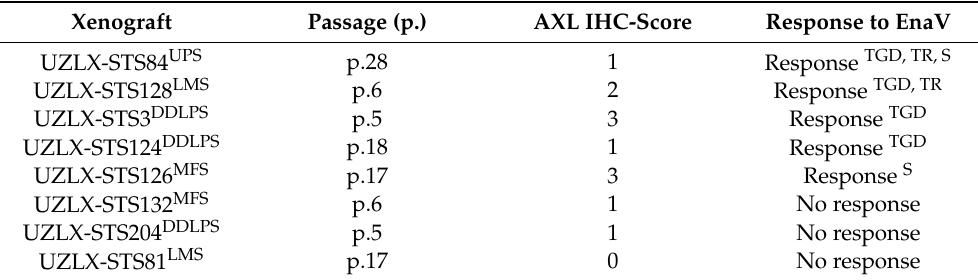
Table 1. The AXL IHC-score and tumor growth response to EnaV-treatment of all sarcoma xenografts included in this study. Xenograft Passage (p.) AXL IHC-Score Response to EnaV UZLX-STS84 UPS p.28 1 Response TGD, TR, S UZLX-STS128 LMS p.6 2 Response TGD, TR UZLX-STS3 DDLPS p.5 3 Response